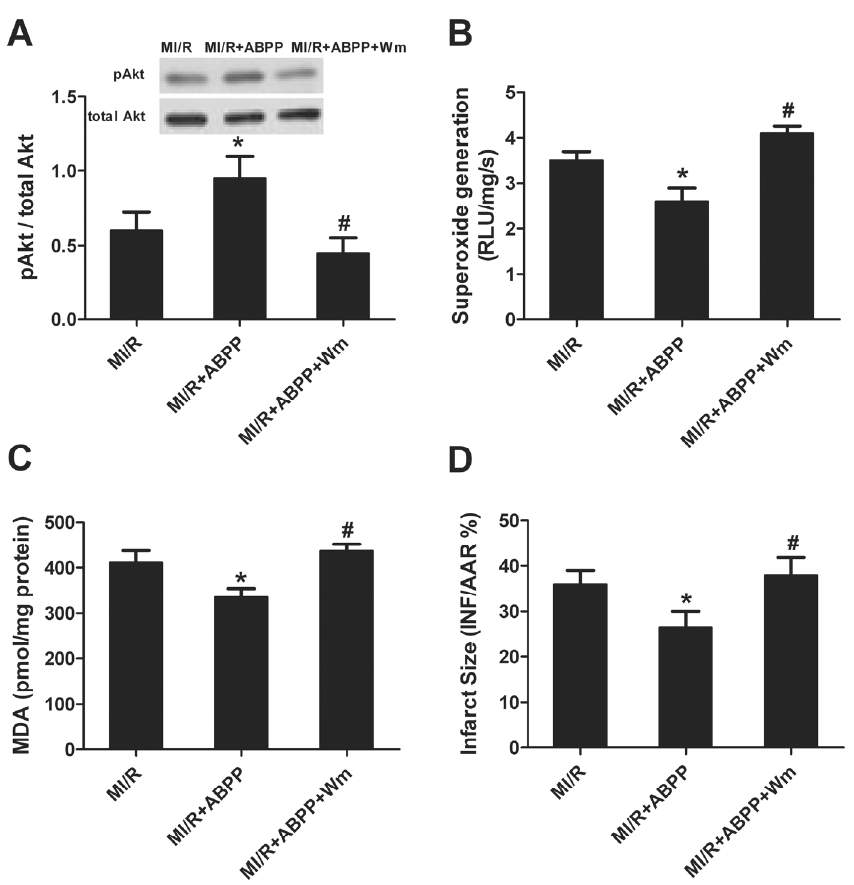
Figure 6. PI3K inhibitor wortmannin inhibited phosphorylation of Akt, increased superoxide generation, malondialdehyde (MDA) and myocardial infarction. ( A ) Phosphorylation of Akt; ( B ) Cardiac superoxide generation; ( C ) Myocardial malondialdehyde (MDA) contents; ( D ) Myocardial infarct size (INF) expressed as percentage of area-at-risk (AAR); MI/R, myocardial ischemia/reperfusion (30 min/4 h); Sham, sham-operated; ABPP, Achyranthes bidentata polypeptides; W, wortmannin.